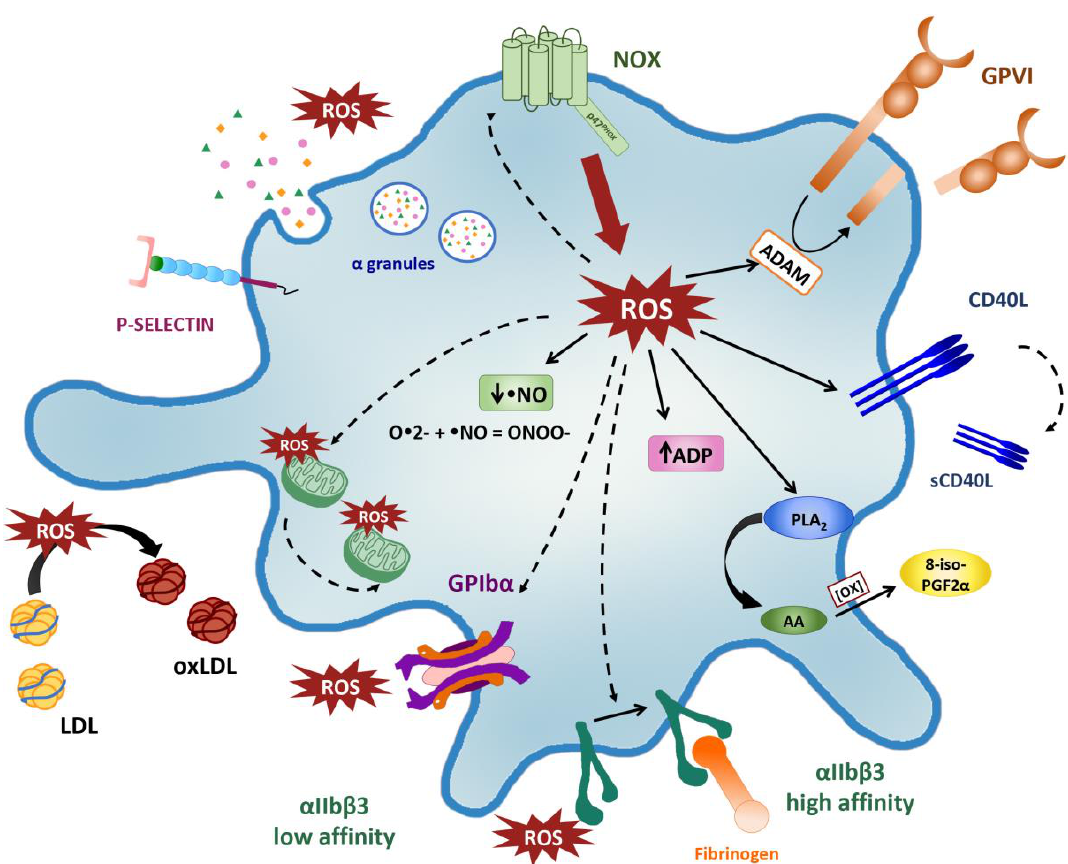
Figure 3. Redox control of platelet activation. NOX-derived ROS boost further ROS production and the consequent platelet activation, adhesion and recruitment in an auto-amplifying loop. Intraplatelet and extracellular ROS regulate platelet receptor (GPIbα and αIIbβ3) binding affinity and GPVI and GPIbα shedding via ADAMs. NOX-derived ROS also regulate ADP and •NO bioavailability, α granules release and P-selectin exposure on platelet membrane. ROS potentiate the PLC γ / PKC / MAPKp38 signaling cascade, thereby inducing PLA2 activation and 8-iso-PGF2 α formation. ROS upregulate CD40L surface expression and release in response to platelet agonists. Upon secretion in the vascular lumen, platelets-derived ROS promote the oxidation of circulating LDL. NOX-derived ROS induce GPIIb / IIIa; GPVI: glycoprotein VI; ADAM: disintegrin and metalloproteinase; ADP: adenosine